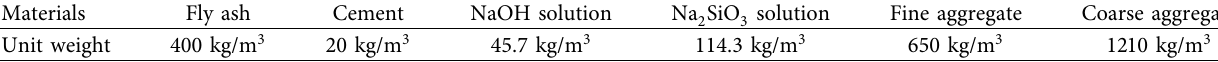
Table 2: The mix proportion of geopolymer concrete